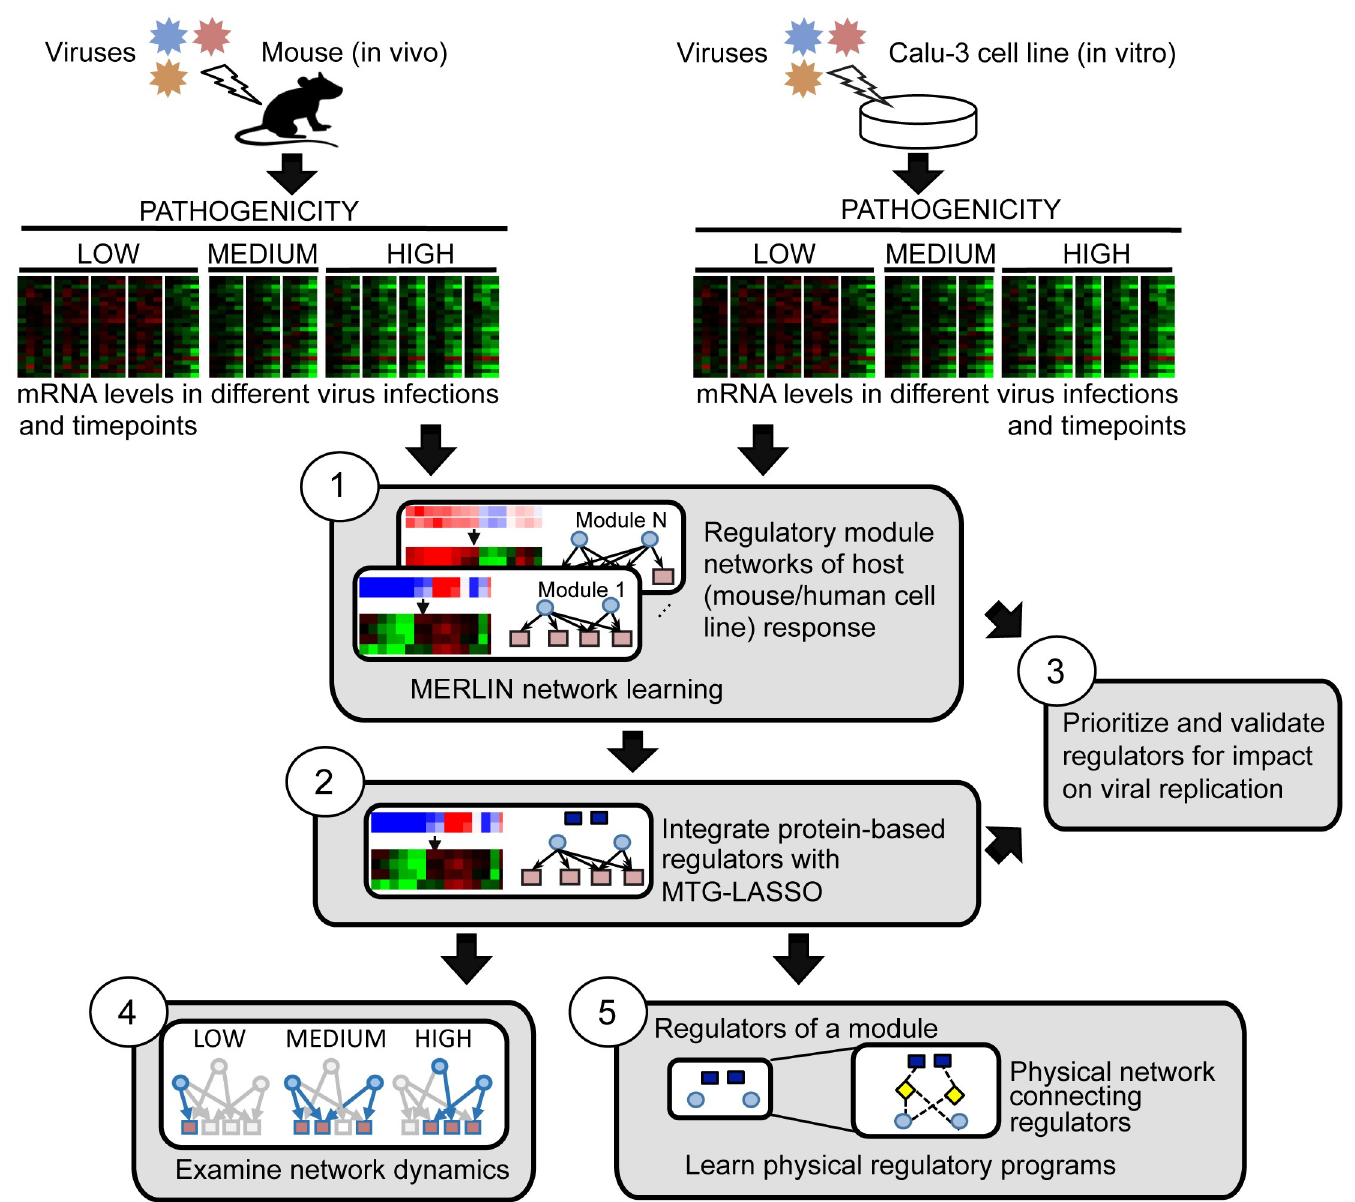
Fig 1. Integrative inference of regulatory networks controlling host response to influenza infection. The main components of our approach are: (1) MERLIN to learn regulatory networks and modules from genome-wide host mRNA profiles from multiple independent virus infections, (2) Multi-Task Group LASSO (MTG-LASSO) approach to predict protein-level regulators (dark blue squares) of mRNA-based modules, (3) construction of active network components for different virus strains and time points, (4) siRNA-based validation of predicted regulators, (5) predicting upstream signaling networks for each module by identifying minimal physical subnetworks that connect module regulators (dark blue squares and light blue ellipses) with a small number of intermediate nodes (yellow diamonds).